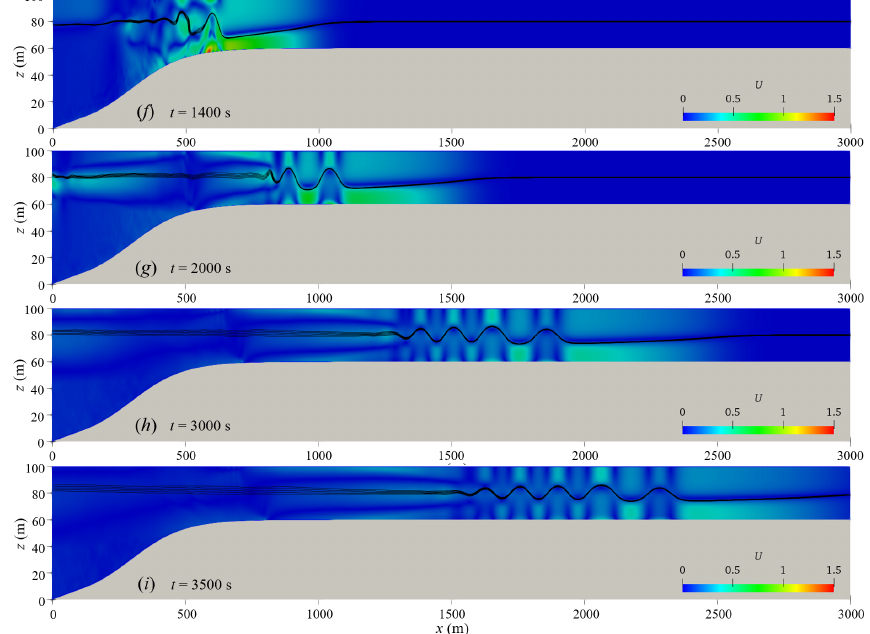
Figure 21. Velocity field diagram of ISW propagation (the black solid line is the iso-density contours, t = 1400 to 3500s).